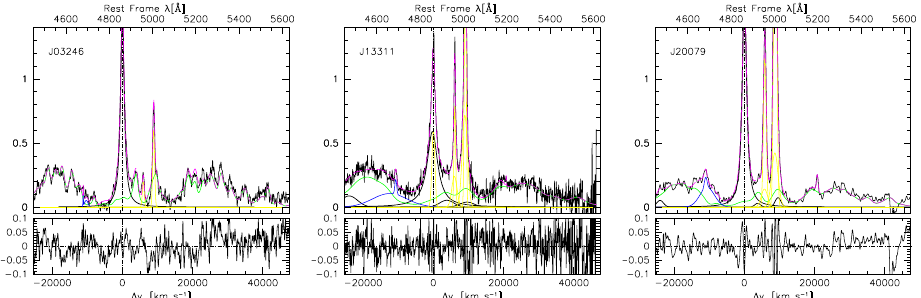
Figure 5. Non-linear χ 2 multi-component analysis with a solid Fe II template (green) of three jetted NLSy1s with γ -ray detections. The spectra are shown after continuum subtraction. The thin filled line traces the observed spectrum. The dashed magenta line represents the model, and the thick black line the H β BC . The [O III ] λλ 4959,5007 is shown in yellow. The lower panel show the residuals of the subtraction of the model from the observed spectrum. From left to right panel, J03246+341, J13311+305, and J20079-445.